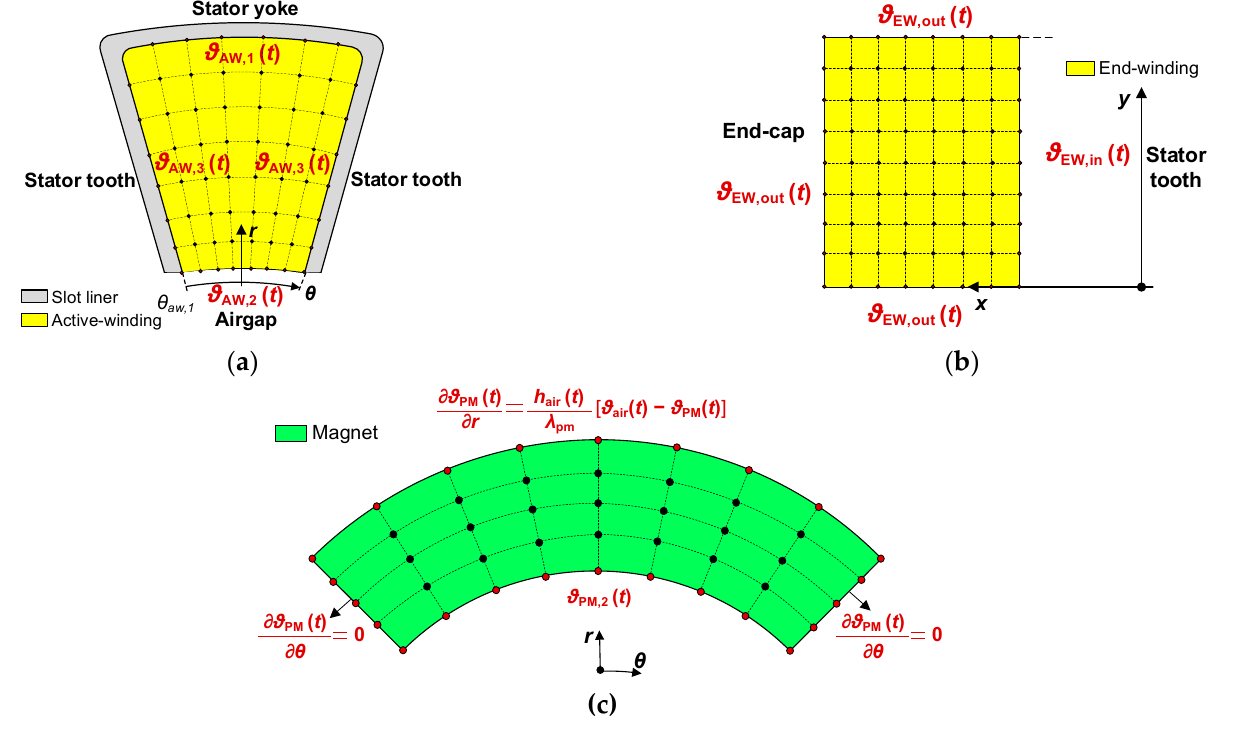
Figure 37. Schematic diagrams of finite difference method based SDTMs [85]. ( a ) Active-winding. ( b ) End-winding. ( c ) PM.